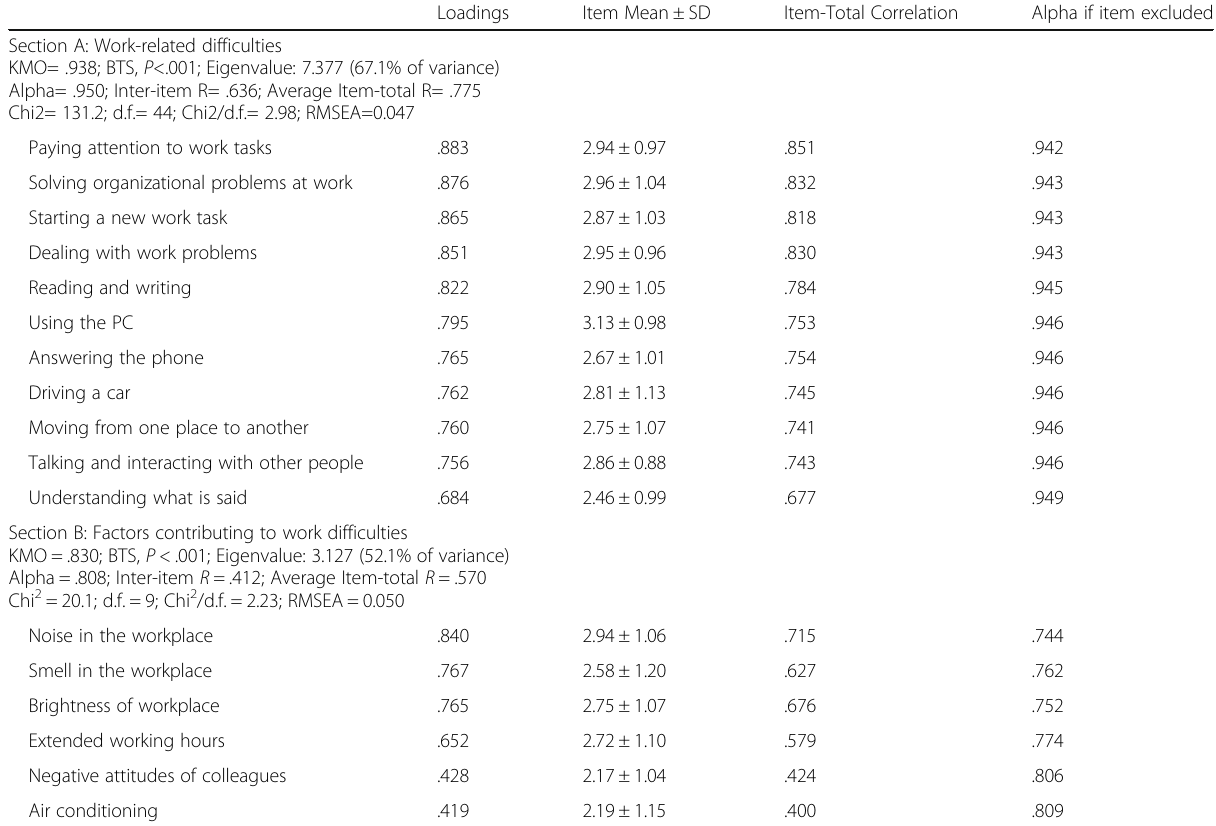
Table 2 Factor analysis and reliability data of HEADWORK questionnaire ( N = 373) Loadings Item Mean ± SD